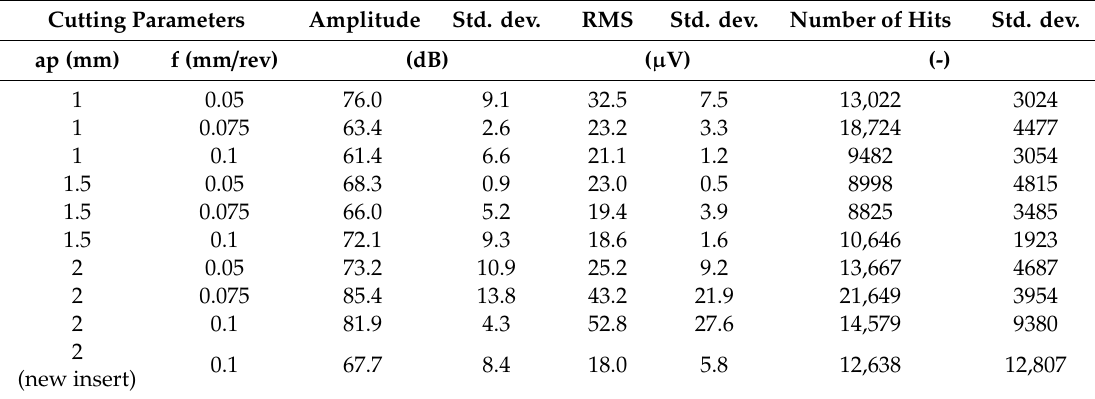
Table 7. Average values of chosen parameters recorded during research. Cutting Parameters Amplitude Std. dev. RMS Std. dev. Number of Hits Std.